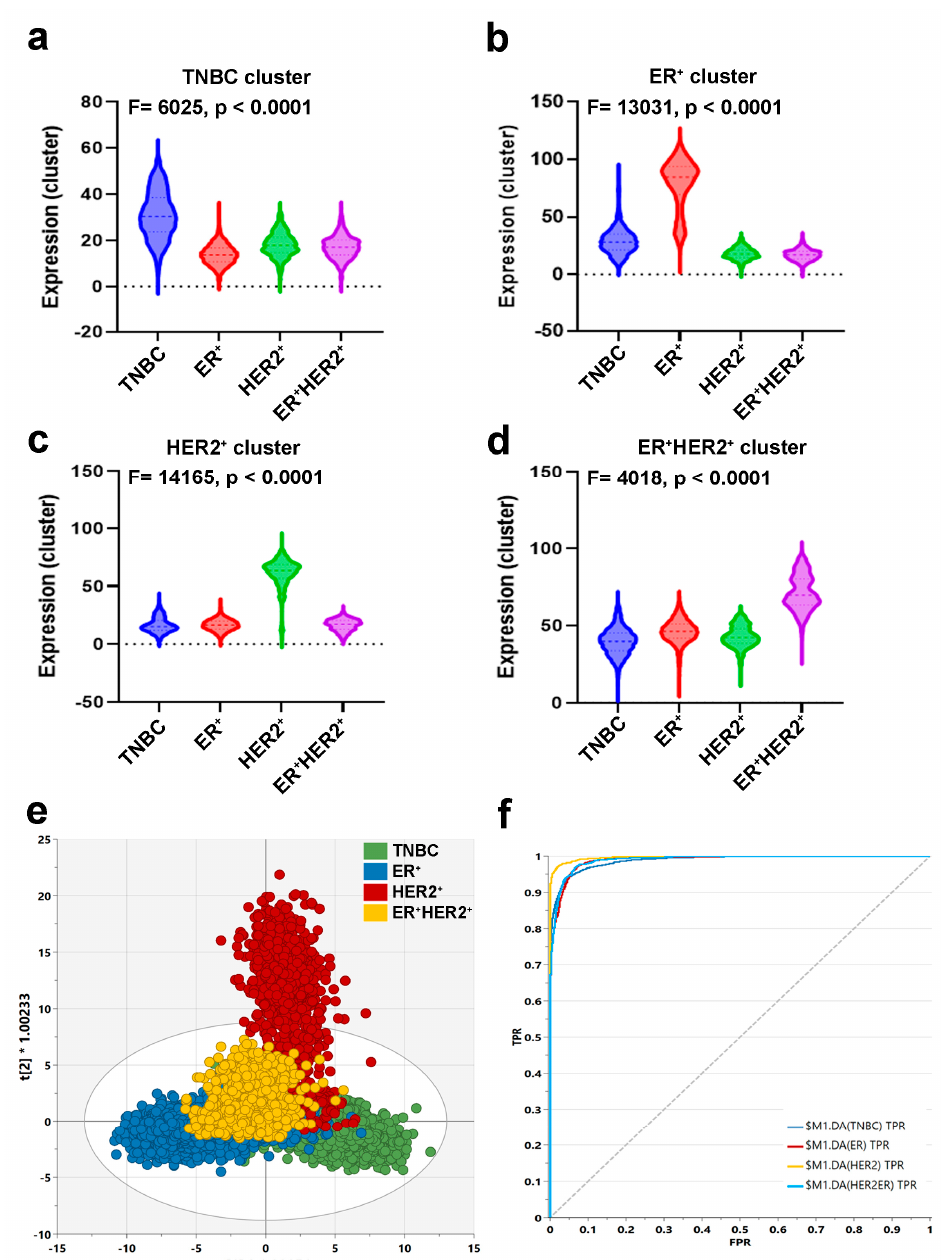
Figure 3. Discriminative analysis based on the identified gene markers. Anova analysis for the identified gene markers enriched in TNBC ( a ), ER + ( b ), HER2 + ( c ), and ER + HER2 + ( d ). Sum score from the identified gene markers for each BC subtype were used for Anova analysis. ( e ) OPLS-DA score plot for the di ff erent BC molecular subtypes based on the identi fi ed gene markers. ( f ) ROC analysis of the identi fi ed gene markers comparing the four BC molecular subtypes.